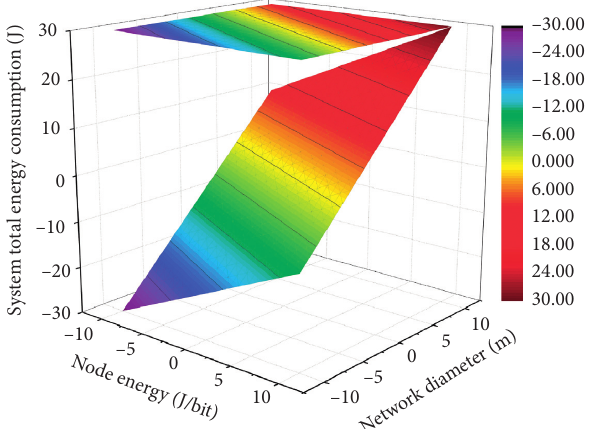
Figure 6: Comparison of energy consumption when network diameter and node energy change.